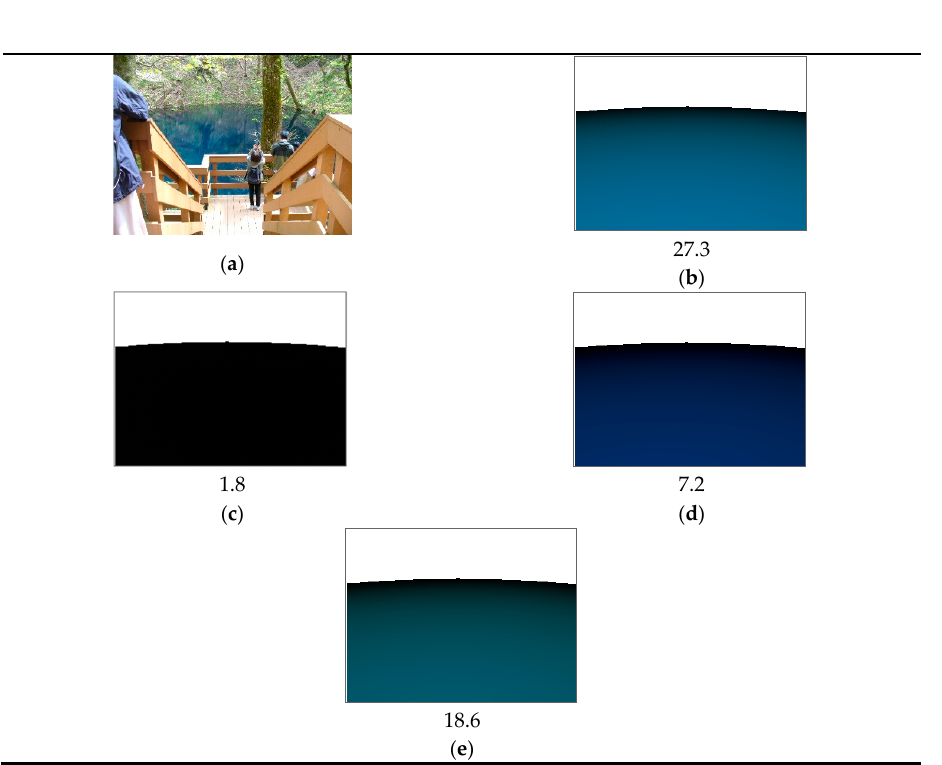
Figure 15. Simulation results for Ao-ike Pond image; ( a ) Image taken at 12:28 (JST) of 24 April 2021, standardized by digital camera sensitivity, ( b ) sum of contributions from pond bottom irregular reflection, density fluctuation scattering by water and white Mie scattering, ( c ) contribution from pond bottom irregular reflection only, ( d ) contribution from density fluctuation scattering by water only, ( e ) contribution form Mie scattering only. The numerical values in ( b – e ) indicate relative averaged luminance on the pond surface.